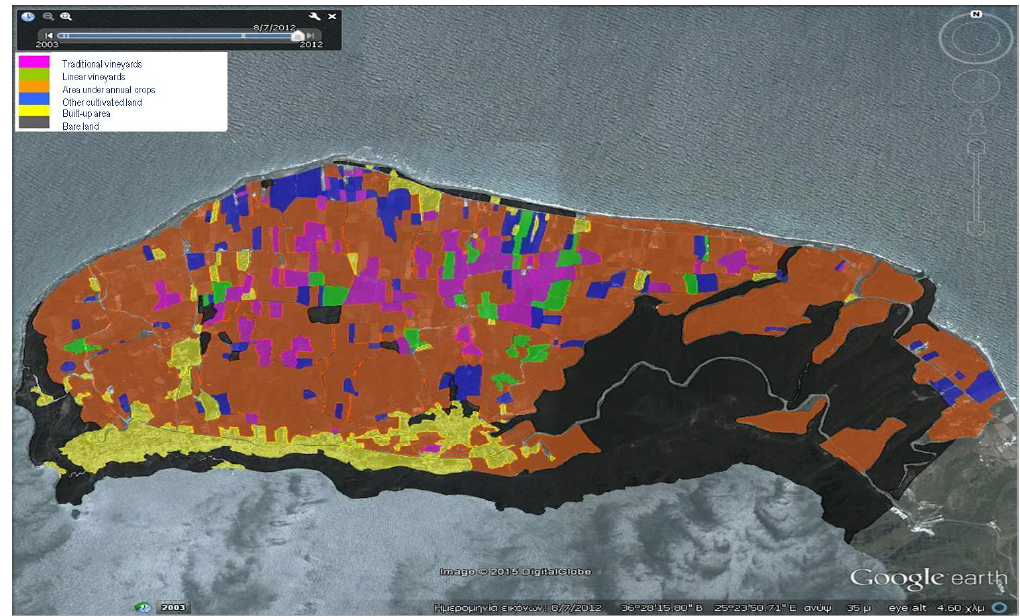
Figure 2. Land cover map of the northern part of Santorini (2012).